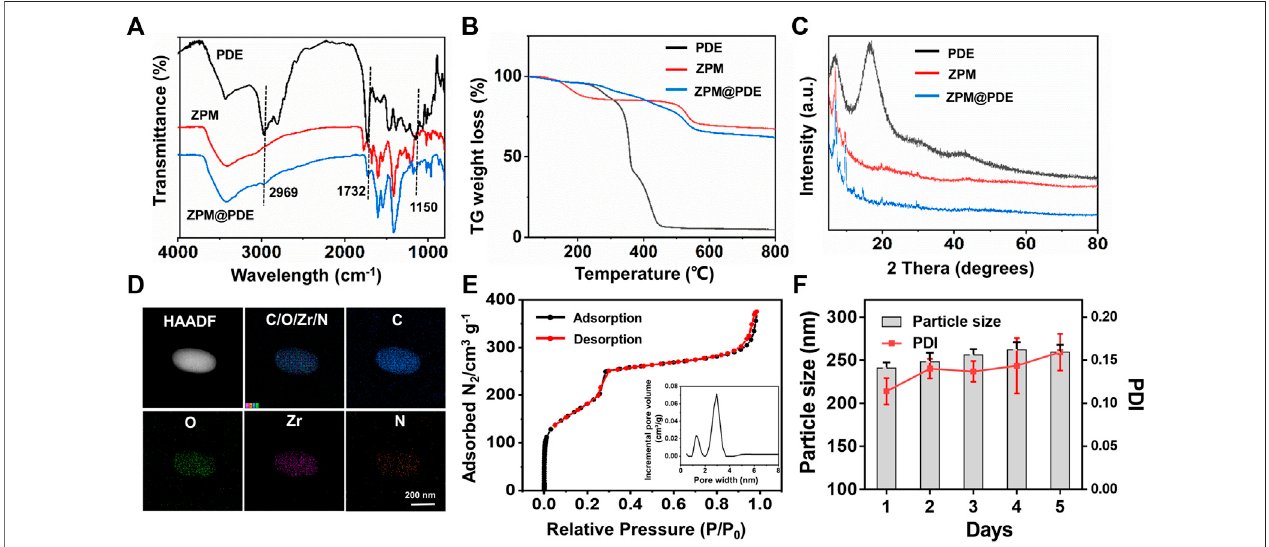
FIGURE 2 | (A) Fourier transform infrared (FT-IR) spectra, (B) TG weight loss pro fi les, (C) XRD patterns of PDE, ZPM, and ZPM@PDE, (D) HR-TEM and elemental mappingimagesofZPM@PDE, (E) N